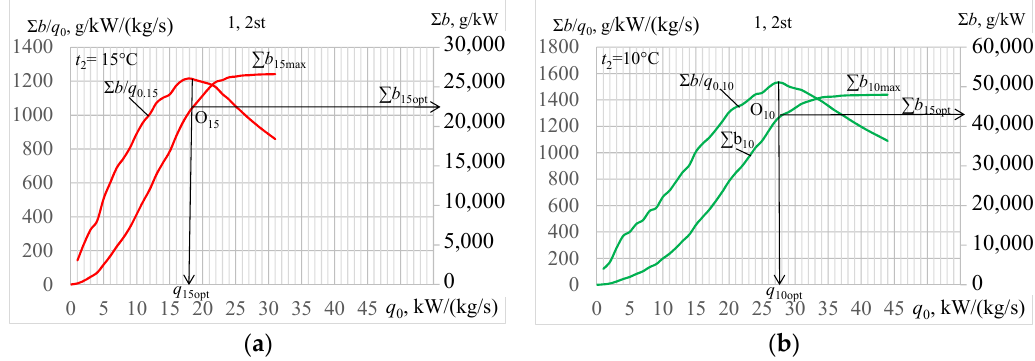
(cid:80) (cid:80) Figure 8. Annual specific fuel reduction ∑ b and its relative increment ∑ b / q 0 due to cooling ambient b and its relative increment b / q 0 due to cooling ambient air Figure 8. Annual specific fuel reduction (cid:80) air to t a2 = 15 °C ( a ) and 10 °C ( b ) against specific cooling capacity q 0 : q 0.opt and ∑ b opt —optimal values. b opt —optimal to t a 2 = 15 ◦ C ( a ) and 10 ◦ C ( b ) against specific cooling capacity q 0 : q 0.opt and